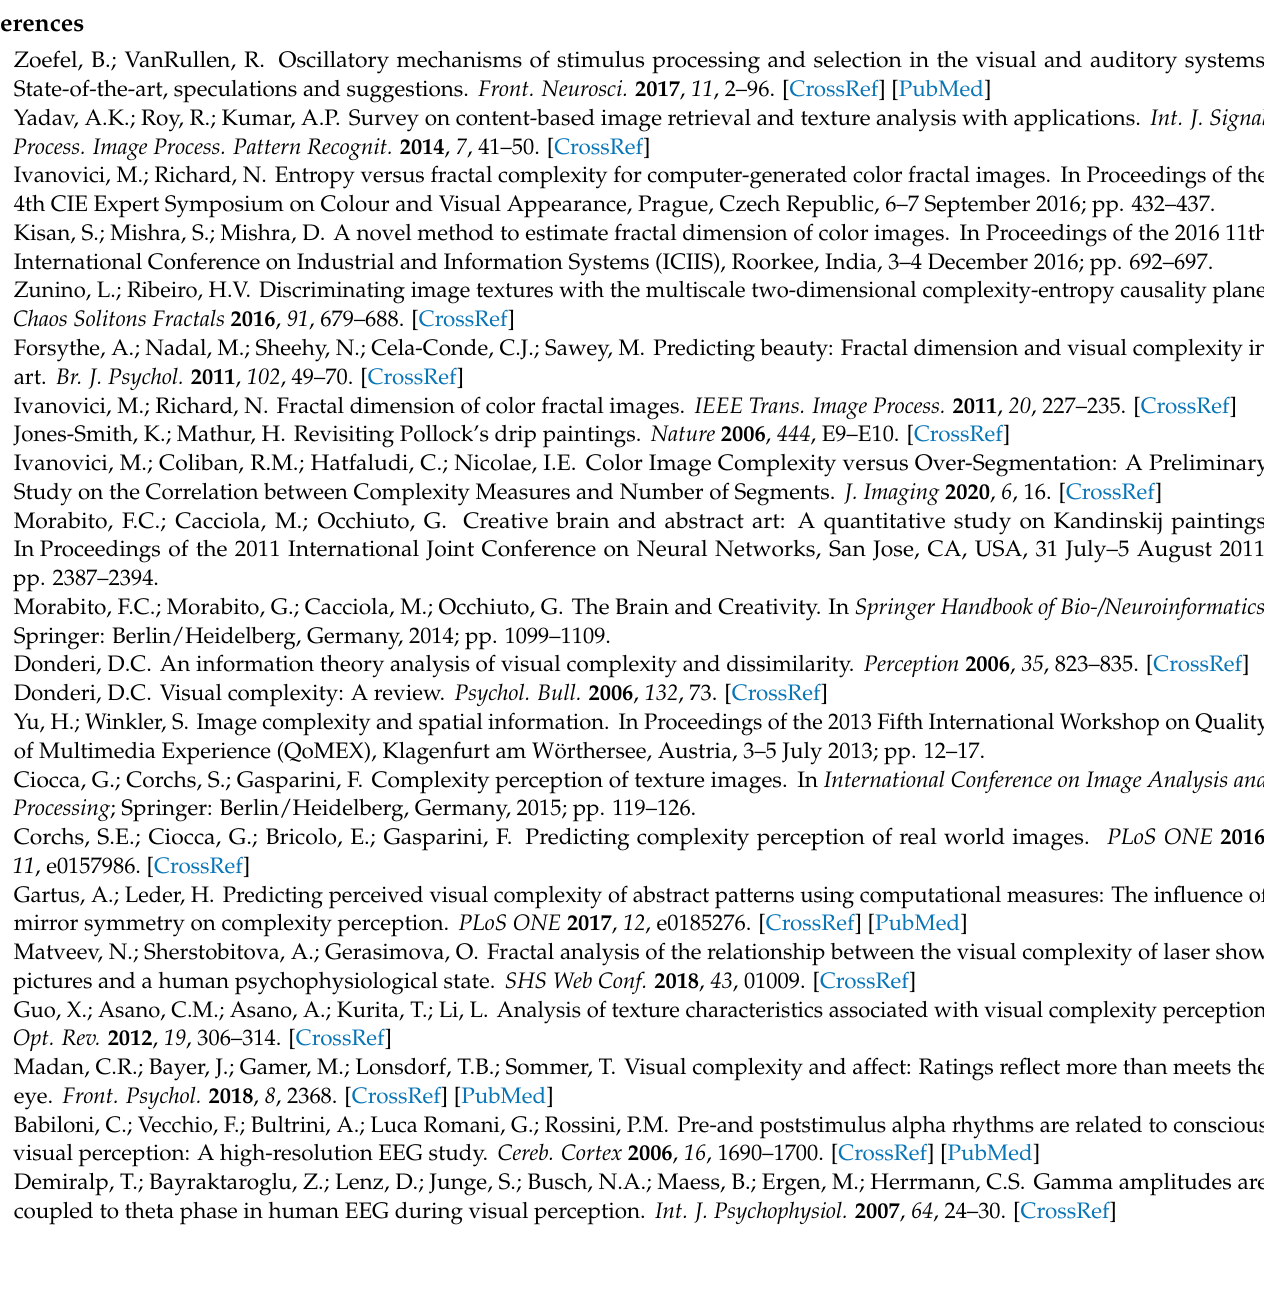
Figure A6. ERSP over all blocks for Frac perception at P3 and T4, bootstrapping α =